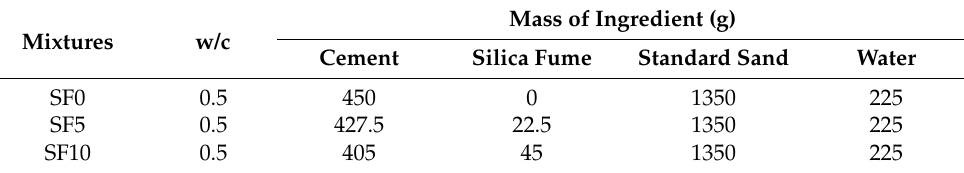
Table 2. Mixing proportion of mortar